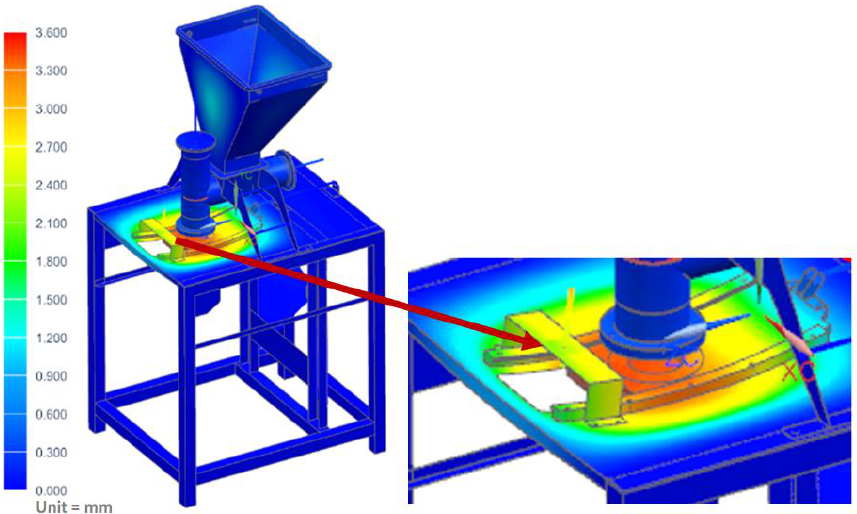
Figure 16. Displacement map of the molding module: pusher of the vertical dispenser is blocked.